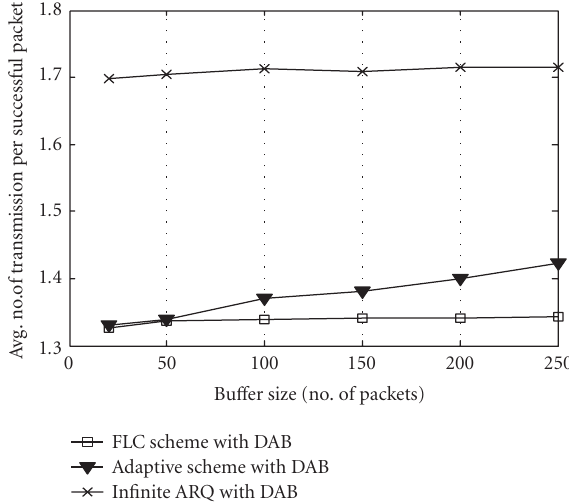
Figure 12: Mean number of transmission for three DAB-based schemes with changing bu ff er